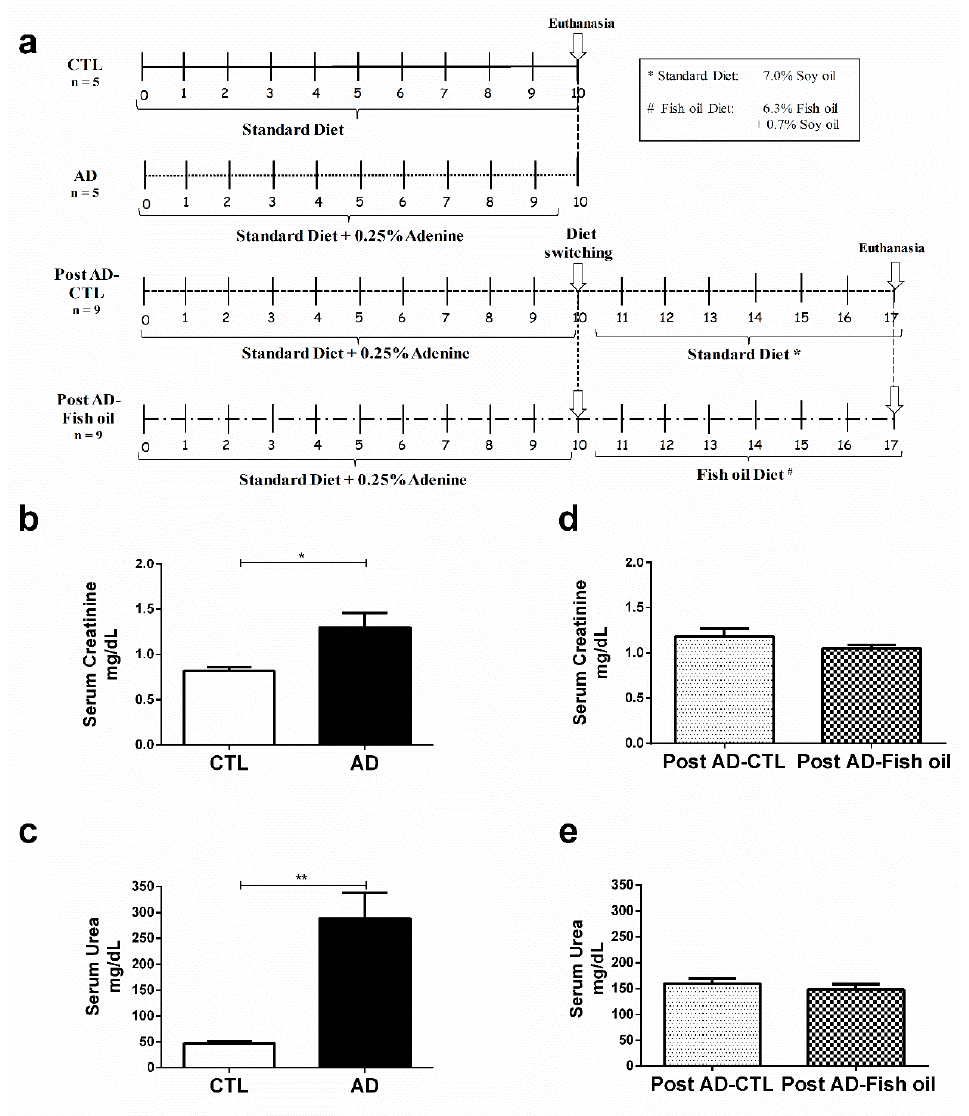
Figure 1. Experimental design and assessment of renal function: ( a ) experimental design, ( b ) serum creatinine, and ( c ) urea from the standard diet (CTL) and adenine (AD) mice. ( d , e ) Serum creatinine urea of Post AD-CTL and Post AD-Fish oil animals. (* p < 0.05, ** p < 0.01).